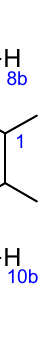
Figure 15. The atoms numbering of the organic molecule. For the Cd 3 Cl 13 anion, the cadmium ions have positive charges, while all chlorine atoms have negative charges. For the organic cations, Cl7 has a negative charge of − 0.075, while Cl9 has a positive charge of 0.262. The nitrogen atoms N8 have a positive charge of 1.487, while the N10 has a negative charge of − 1.070. The carbon atoms C1, C5 and C6 have positive charges, while C2, C3 and C4 have negative charges. It is worth noting that hydrogen atoms in the range 0.206–0.523 carry a positive